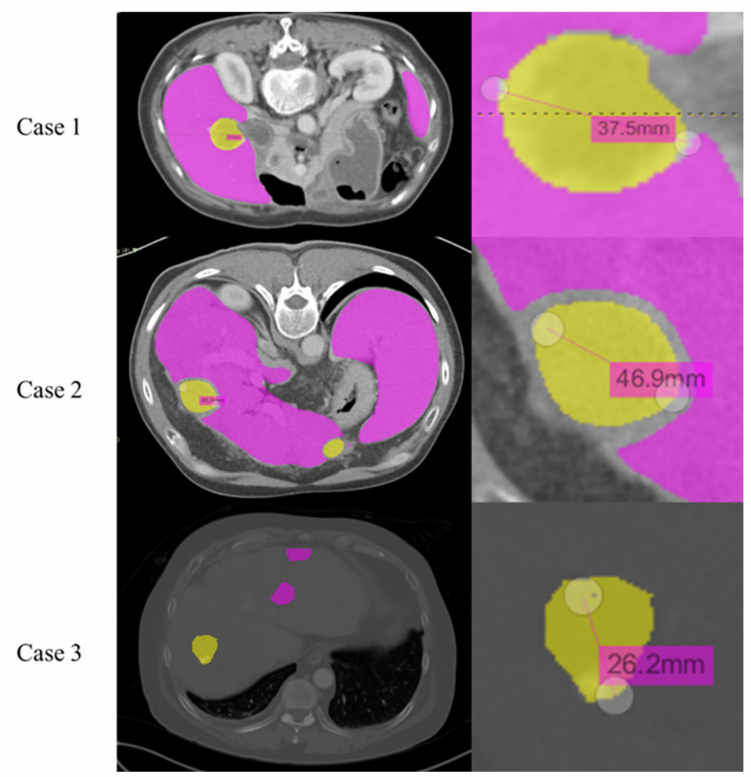
Figure 4. Interface image for measuring liver and lesion length in the LIFEx